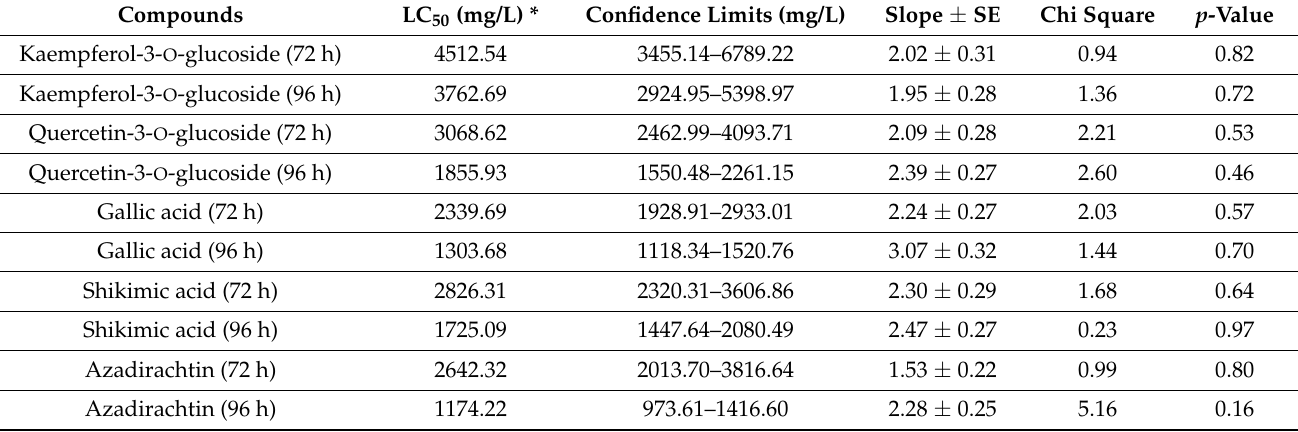
Table 5. Efficacy of compounds isolated from leaf fractions of Triadica sebifera against Aphis craccivora .